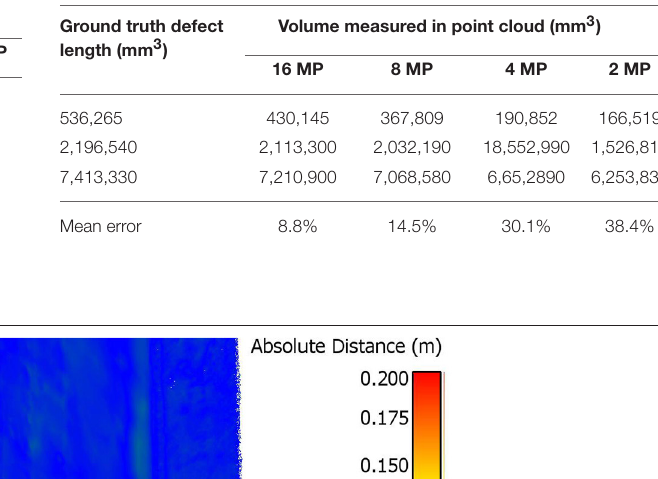
TABLE 9 | Measurement accuracy of Type 3 volumetric defects at various image resolutions.